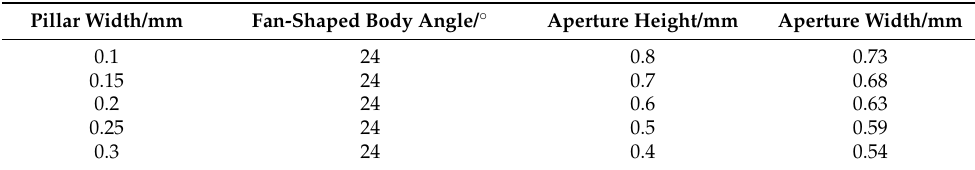
Table 1. Basic unit model parameters of each sector